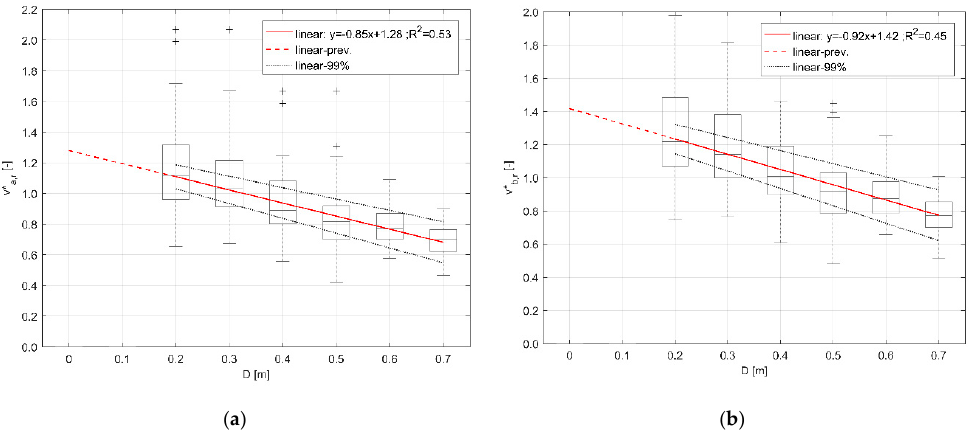
Figure 5. Normalized speed variation for running conditions depending on D in respect to dry surface motion conditions, for the whole sample (male and female together): ( a ) according to the curve a [46]; ( b ) according to the curve b [43]. Linear regressions (dashed lines refer to prevised values outside of the tested D range) and boundary conditions (99%) are shown. Outliers are shown in the boxplot representation (marked by “+”).